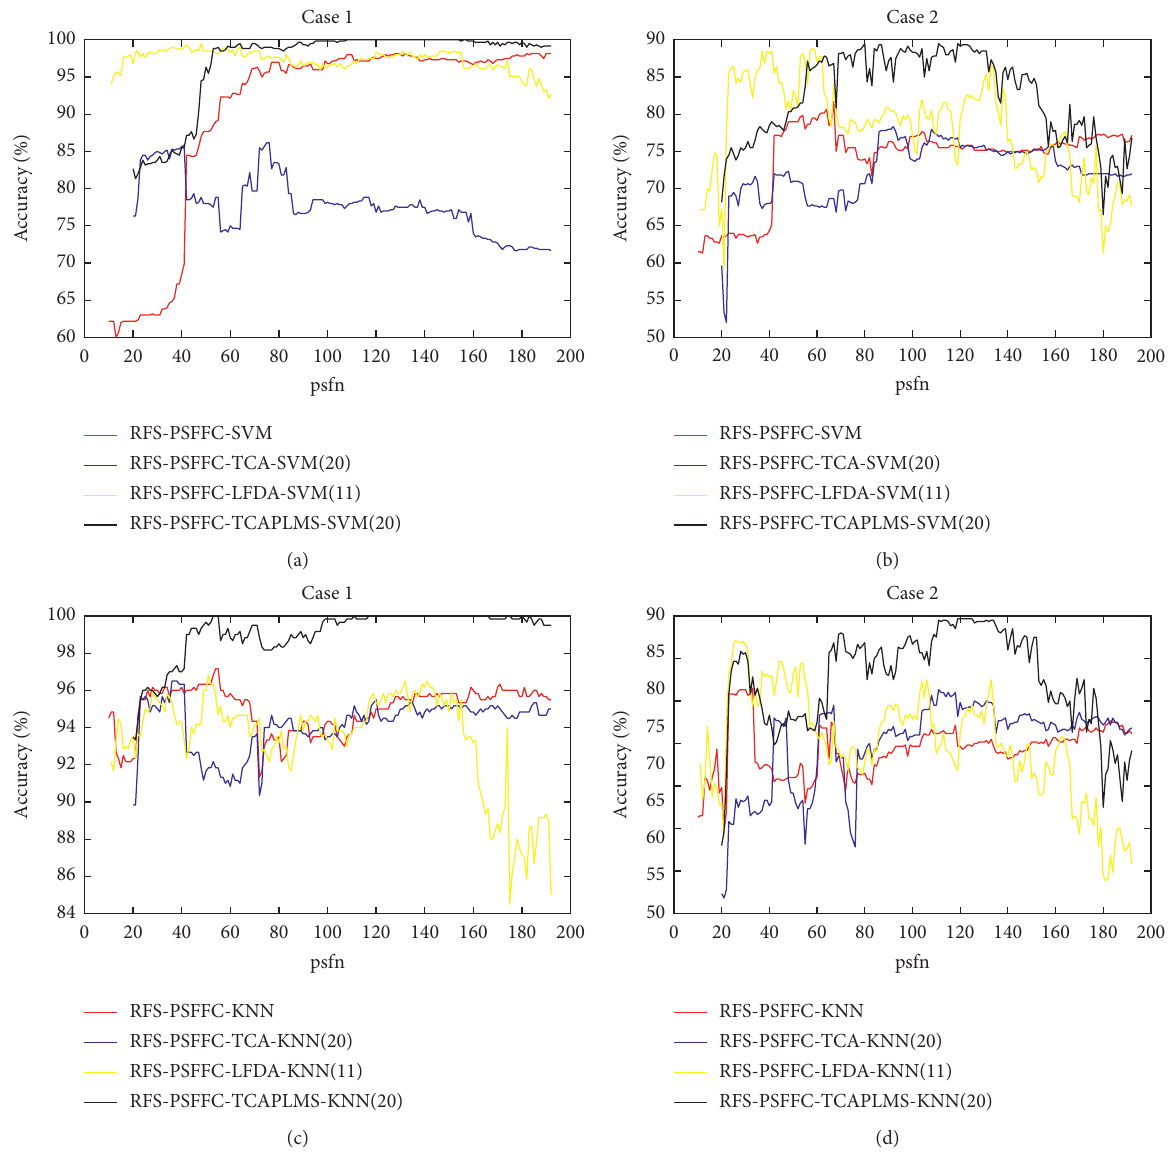
Figure 34: The testing accuracies of models with the use of PSFFC, TCA, LFDA, and TCAPLMS. Table 6: Testing accuracies of RFS-LFDA-SVM and RFS-LFDA-KNN. RFS-LFDA-SVM RFS-LFDA-KNN Dimension size